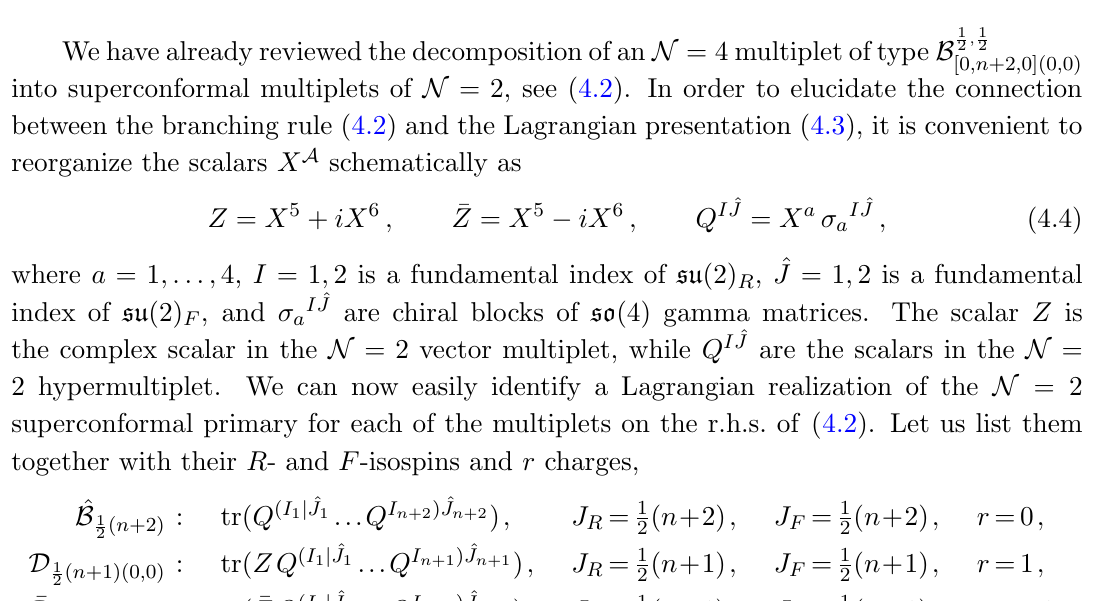
Table 1 . Families of Schur operators of N = 4 super Yang-Mills theory. For each family we give the N = 2 supermultiplet in the notation of [37], the schematic form of the superprimary in the multiplet, and the schematic form of the Schur operator. The quantum numbers (cid:1), h , J F are the 4 d scaling dimension of the Schur operator, the 2 d holomorphic dimension of the chiral algebra element, and the half-integer sl (2) F spin of both, respectively. The scalar (cid:12)elds Q , Z , (cid:22) Z are de(cid:12)ned in (4.4), while (cid:21) , ~ (cid:21) denote the gaugini in N = 2 language, which are a subset of all gaugini in N = 4 language. The KK modes are given in the notation of [51]. All families are labelled in such a way that the range of n is n = 0 ; 1 ; 2 ; : : :